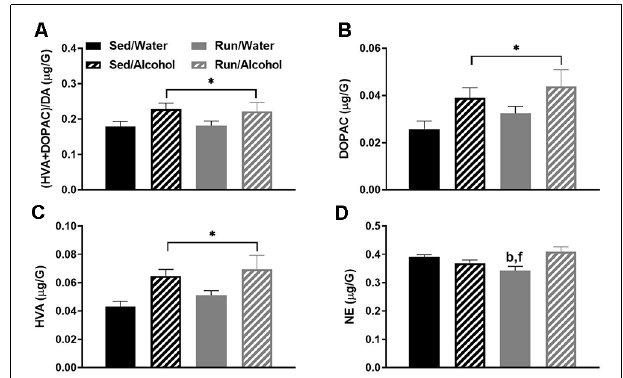
FIGURE 6 | Neurochemical levels in the mouse caudal cortical area immediately following the final DID session. Ratio of (HVA + DOPAC)/DA (A) , DOPAC concentrations (B) , HVA concentrations (C) , and NE concentrations (D) . Data represent means +SEM. ∗ P < 0.05 main effect alcohol access,